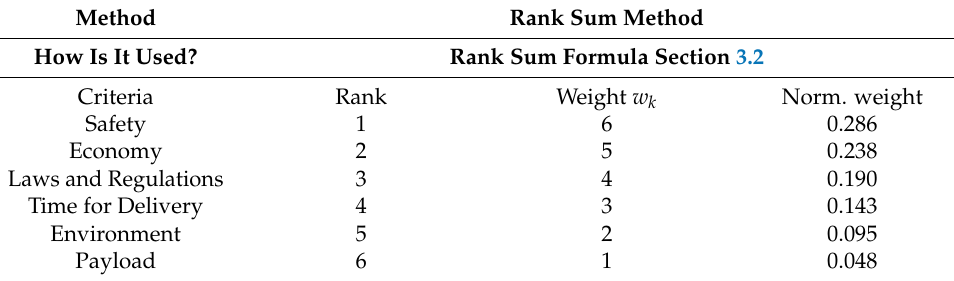
Table 10. Rank sum method for weighting criteria.